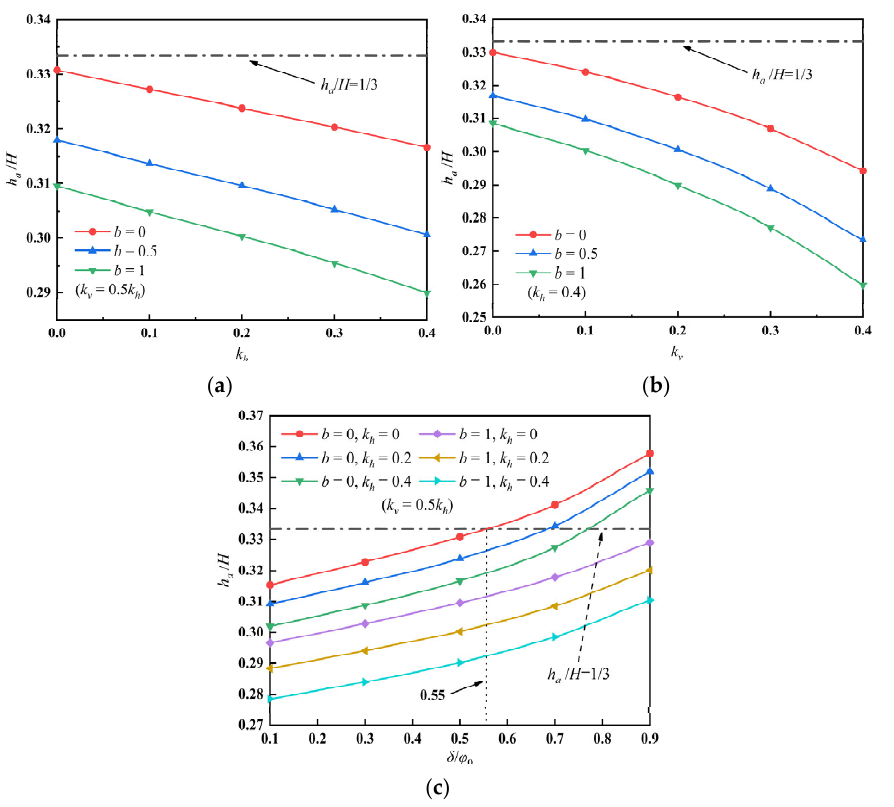
− h a ; ( b ) k v − h a ; ( c ) δ − h a